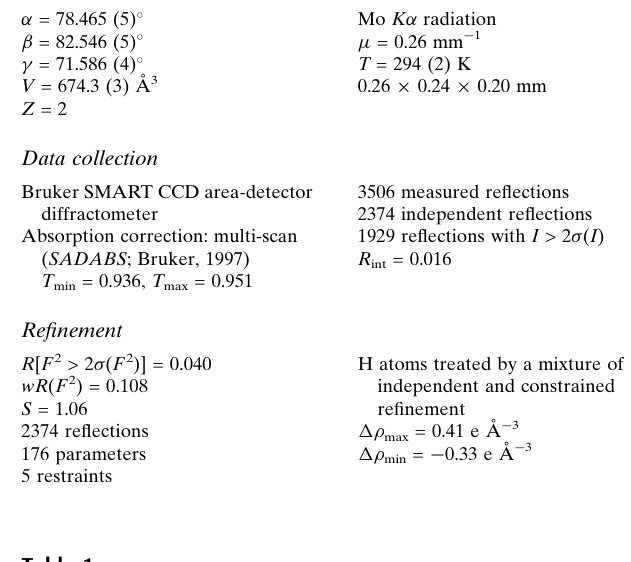
Hydrogen-bond geometry (A˚ , (cid:3) ). D —H (cid:1)(cid:1)(cid:1)